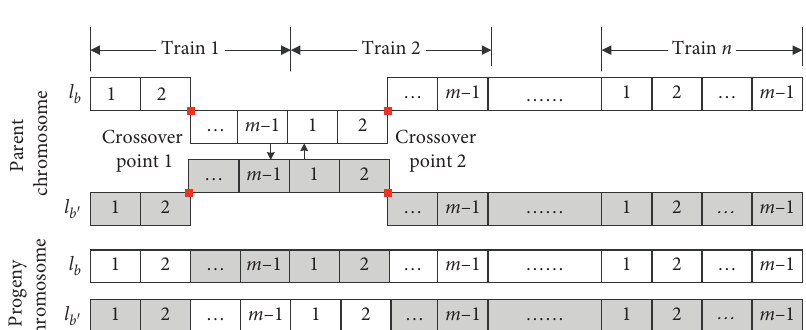
Figure 8: A schematic diagram of the chromosome two-point crossover operator.